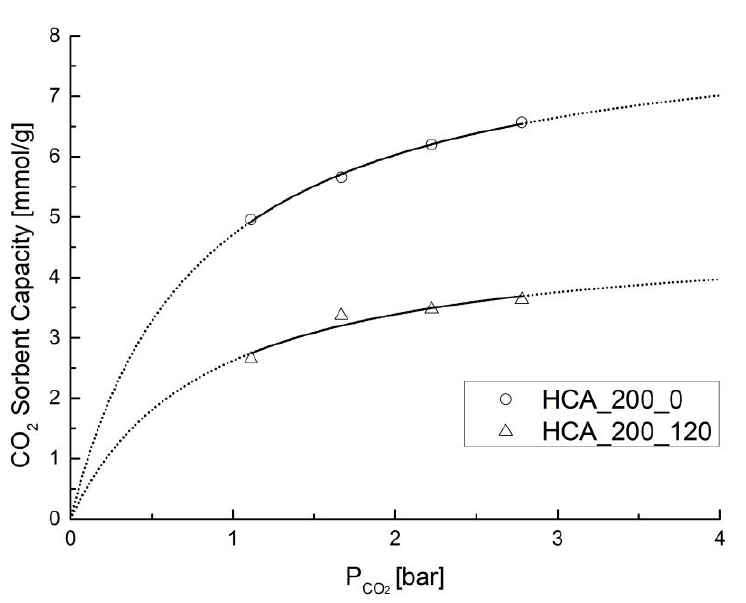
Figure 5. CO 2 sorbent capacity vs. p CO2 .